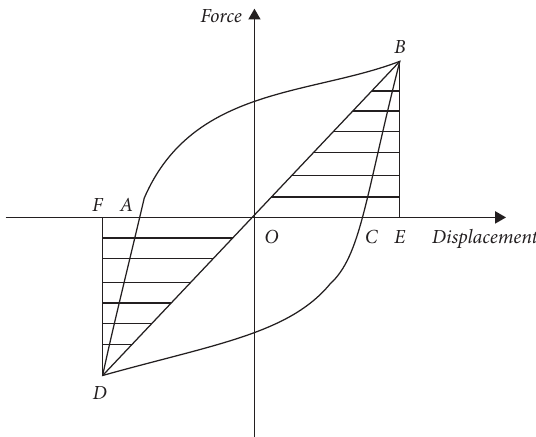
Figure 6: Calculation of the energy dissipation coefficient.